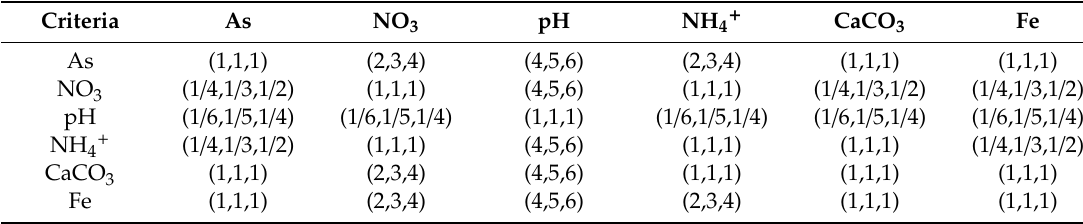
Table 4. Pair-wise comparisons in scenario